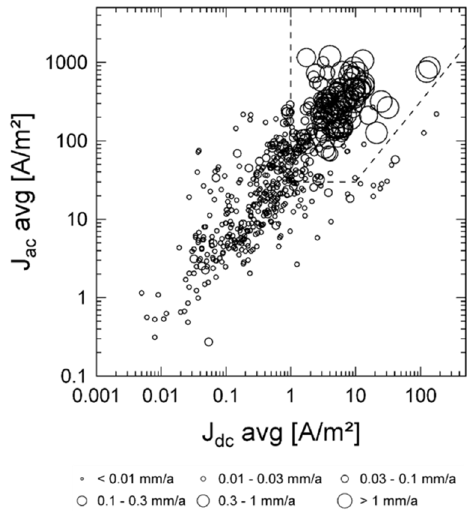
Figure 7. Protection criterion based on AC and DC densities as proposed by Büchler [61]. The region confined by the dotted lines corresponds to very severe AC corrosion and must be avoided.